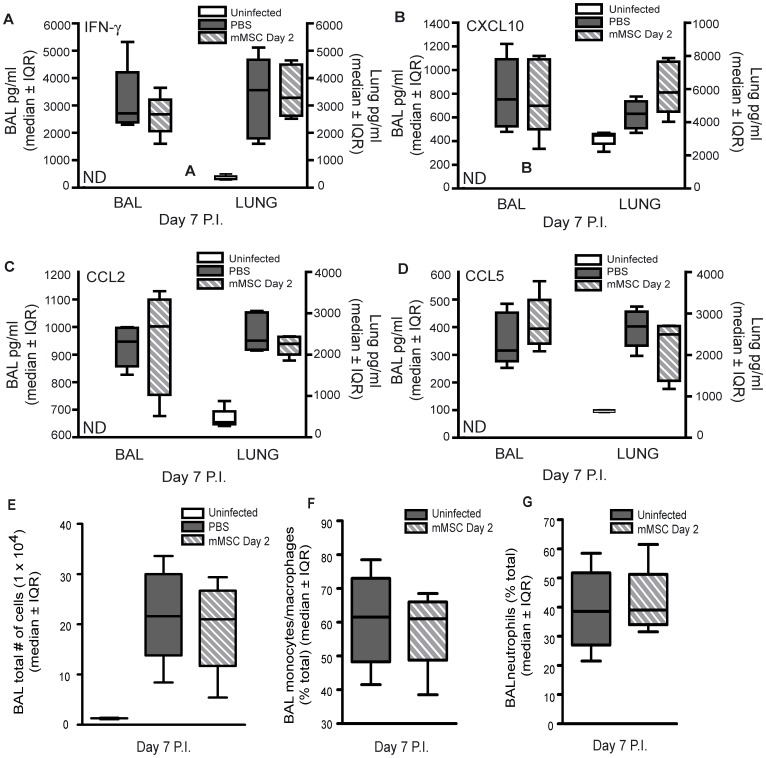
Therapeutic administration of mMSCs failed to decrease pulmonary inflammation or modify BAL inflammatory cell counts in experimental severe influenza.7–10 week-old male C57Bl/6 mice infected with 425 EID50 influenza A/PR/8 virus and administered 2.5×105 mMSCs (passage 6–9) or PBS on day 2 P.I. were sacrificed on day 7 P.I. BAL fluid and lungs were harvested. (A–D) No significant difference in BAL fluid and lung homogenate cytokines and chemokines (IFN-γ, CXCL10, CCL2 or CCL5) was observed for mice administered mMSCs compared to infected control mice administered PBS (One-way ANOVA, n = 4–6/group, representative of 2 independent experiments). (E) The total number of BAL inflammatory cells was similar for mMSC-treated mice and infected control mice administered PBS (one-way ANOVA, n = 6/group). There was no significant difference in the total percentage of BAL (F) monocytes/macrophages and (G) neutrophils between mice administered mMCS and infected control mice administered PBS (one-way ANOVA, n = 6/group). Error bars represent interquartile range (IQR). ND = nondetectable.